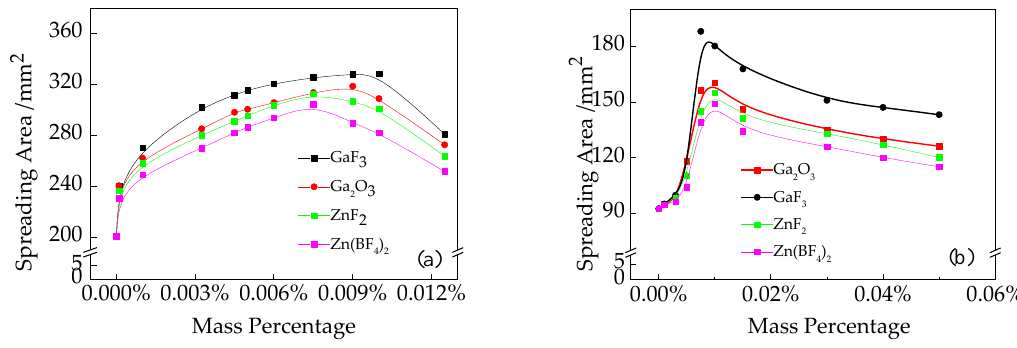
Figure 3. Spreading areas of Zn-15Al filler metal ( a ) 6061 aluminum alloy; ( b ) Q235 steel.